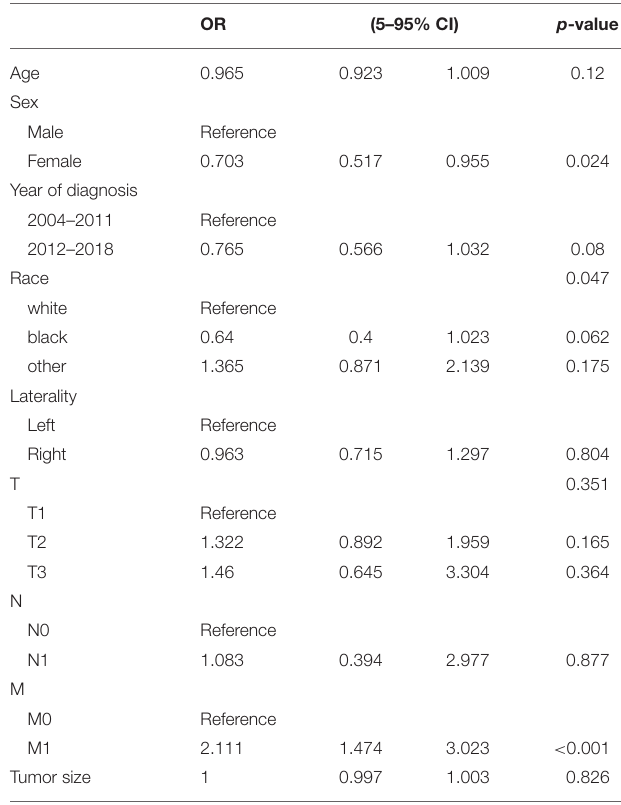
TABLE 2 | Multivariate Logistic regression model to predict limb salvage surgery or amputation in pediatric osteosarcoma